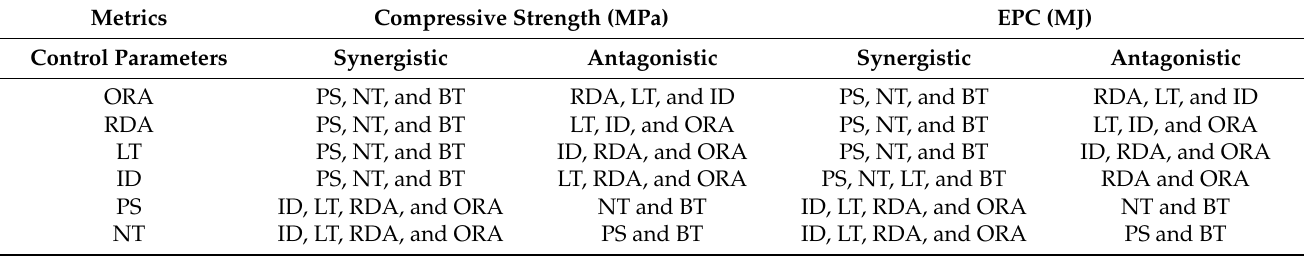
Table 4. Interaction plot